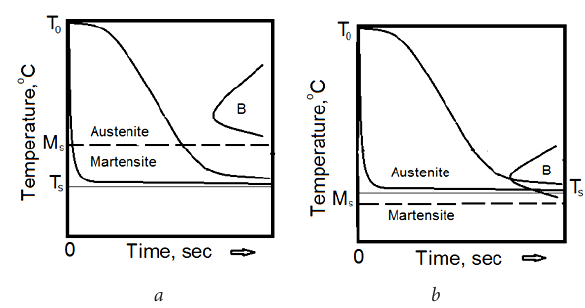
Fig. 4. Relationship: а – martensite start temperature; b – self-regulated thermal process: T S is saturation temperature; M S is martensite start temperature; B is